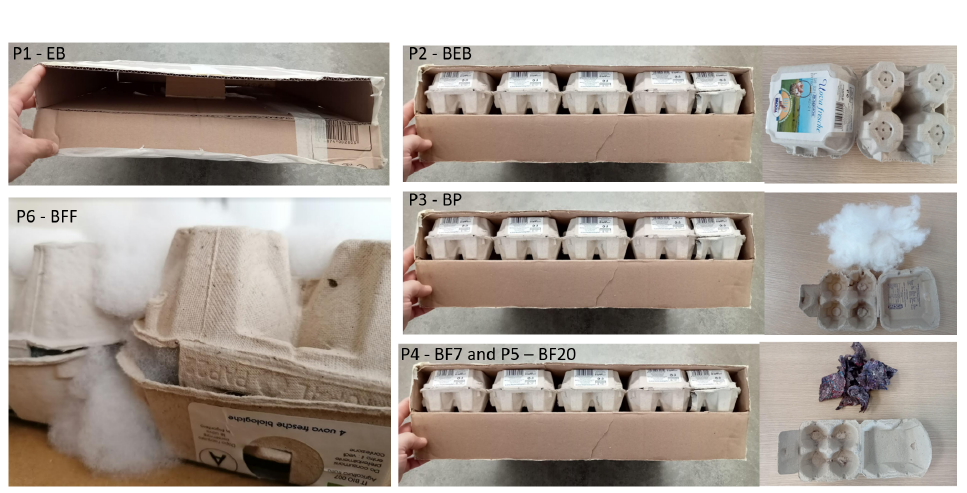
Figure 1. Panels realized for the thermal tests. All the panels are made of egg boxes, except for T1-EB . In panel T6-BFF , the egg boxes have been filled and surrounded by